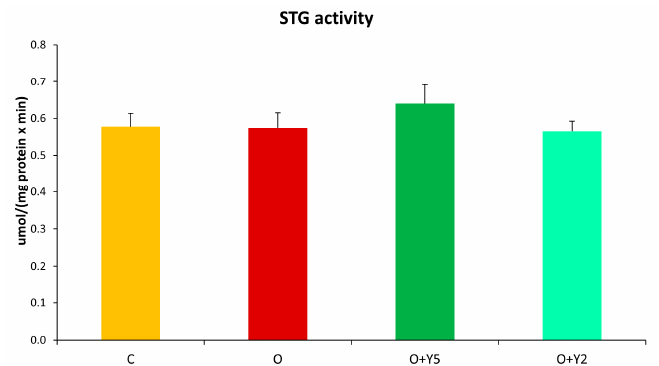
Figure 8. The activity of glutathione-S-transferase (GST) in the livers of rats. C—control rats fed a standard diet; O—rats fed with HFD; O + Y5—rats fed with HFD and treated intraperitoneally (i.p.) with yohimbine at a dose of 5 mg/kg/day for 30 days; O + Y2—rats fed with HFD and treated intraperitoneally (i.p.) with yohimbine at a dose of 2 mg/kg/day. Data are presented as the mean ± SEM, n = 6 per group. Statistical analysis was performed using a one-way ANOVA.